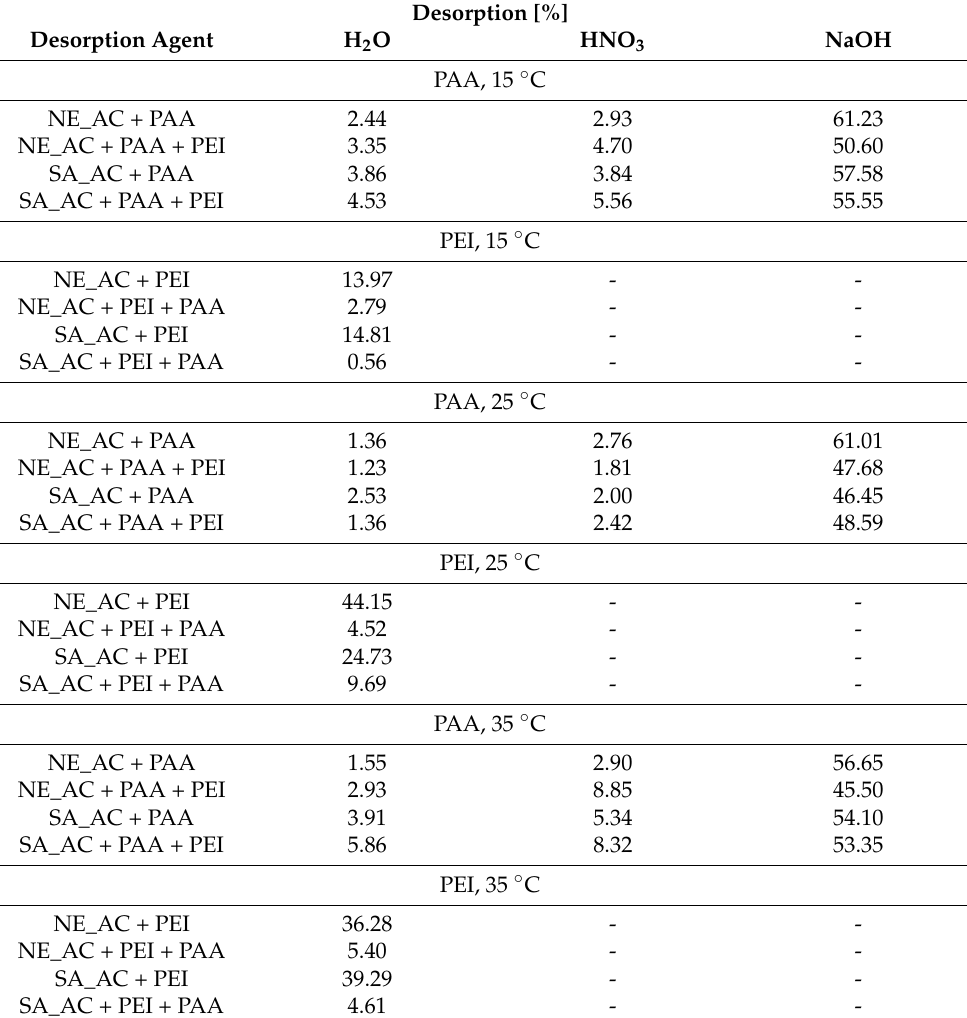
Table 4. Percentage desorption of polymers from activated carbons surface from the single and mixed adsorbate systems under different temperature conditions.